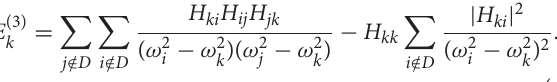
FIGURE 5 | Frequency shifts for the dipole multiplet at ν shifts have to be assigned to mixed states instead of oscillation